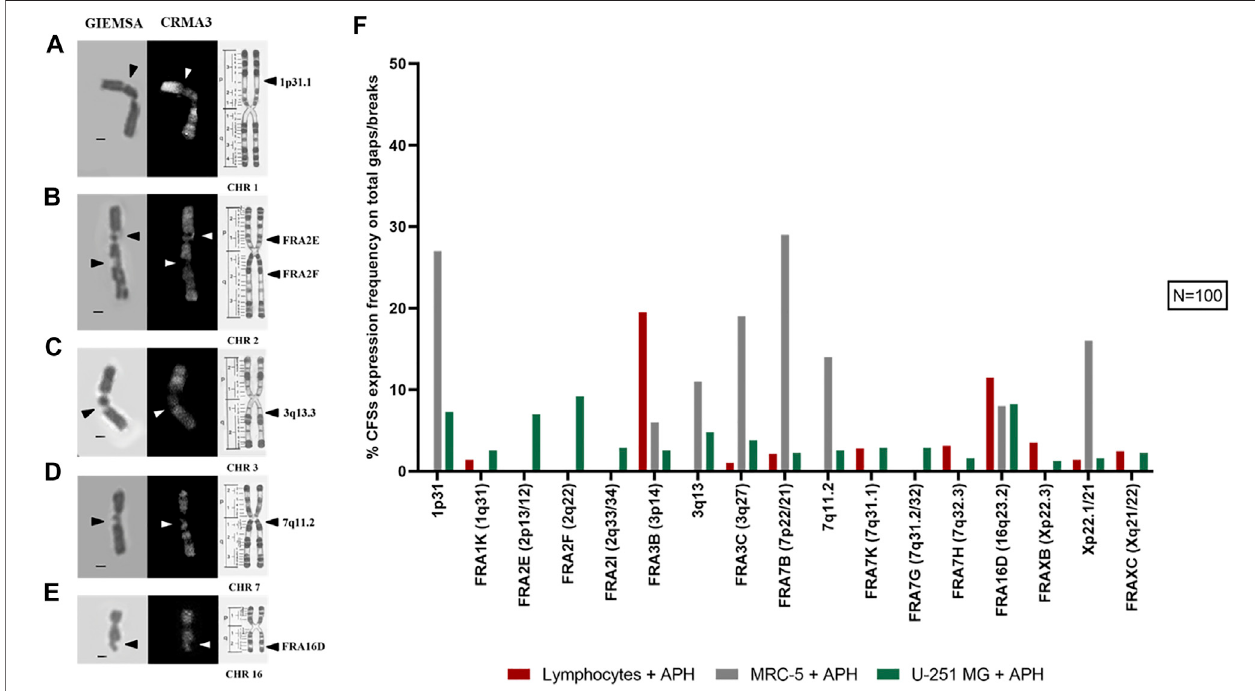
FIGURE 5 | Example images of the most expressed CFSs in U-251 MG cells are shown: 1p31.1 (A) , FRA2E (2p13/12) and FRA2F (2q22) (B) , 3q13.3 (C) , 7q11.2 (D) , and FRA16D (16q23.2) (E) . R-banding by CRMA3 staining allows the recognition of the cytological band where the lesion is localized (chromosome ideogramsaremodi fi edfromthestudybyDutrillauxetal.,1976).Inthegraph (F) ,weseeCFSsexpressedunderAPHtreatmentwithanexpressionfrequencyequaltoat least 1% of the total number of gaps/breaks in lymphocytes, fi broblasts, and glioblastoma cells. Number of metaphases counted for control and APH-treated conditions was 100 ( N (cid:1) 100) for one replicate. CHR, chromosome. Scale bar: 1